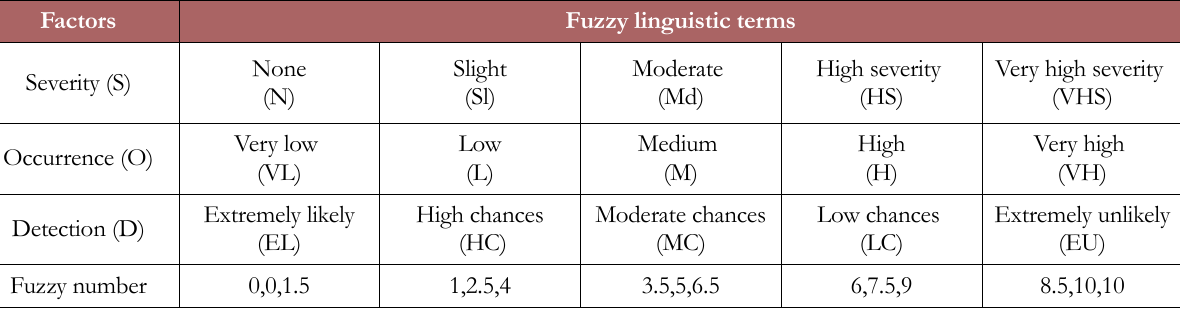
Table 1. Fuzzy linguistic variable assignment for S, O, and D